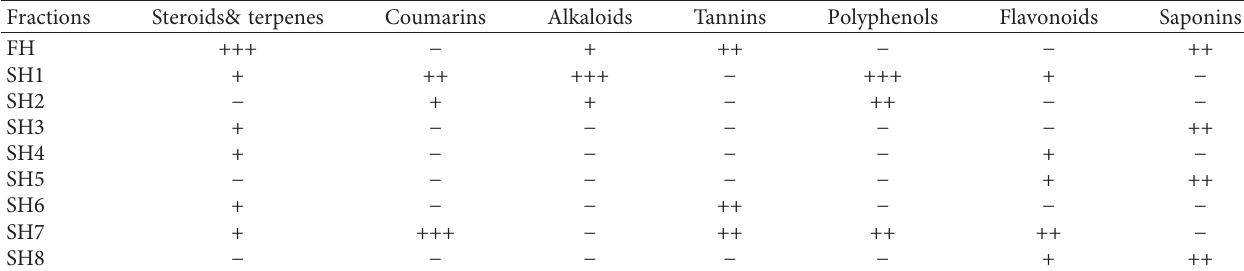
ND: not done. Table 5: Phytochemical screening of the hexane mother extract FH and its fractions.